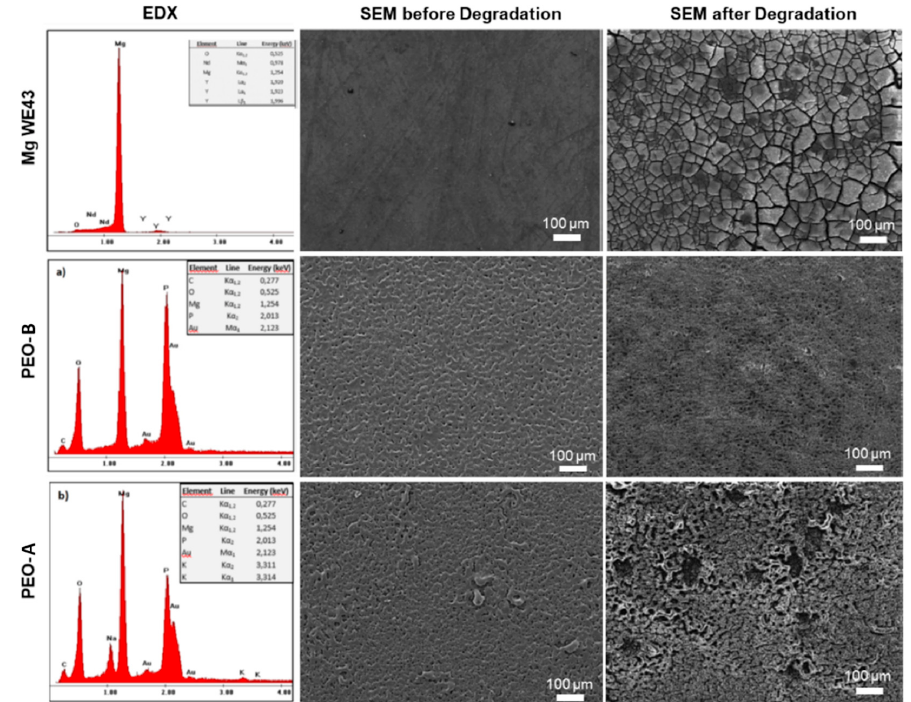
Figure 4. Scanning electron microscopy (SEM) of the surfaces of the Mg specimens (WE43, PEO-B and PEO PEO-A) before and after degradation, revealing a accelerated corrosion attack of the Mg WE43, followed by PEO-A and PEO-B showing almost no change in surface morphology. For the surface of the unprotected Mg WE 43 specimens a smooth surface can be observed, whereas the degradation resulted in a corrosion layer comprising cracks and fissures. In contrast, the PEO treated samples show a micro-structured surface with a microporosity. After degradation, the cavities of the PEO microstructure became more pronounced, while fissures appeared and the surface of the PEO modification turn into a comb-like surface structure with single pittings. These features were significantly more apparent on the PEO PEO-A samples.